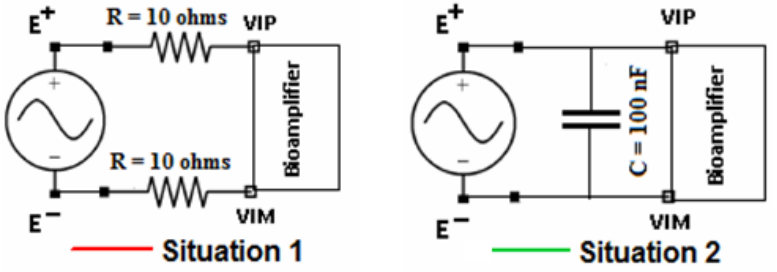
Figure 8. Scenarios for the simulation of the robustness of the LNA.